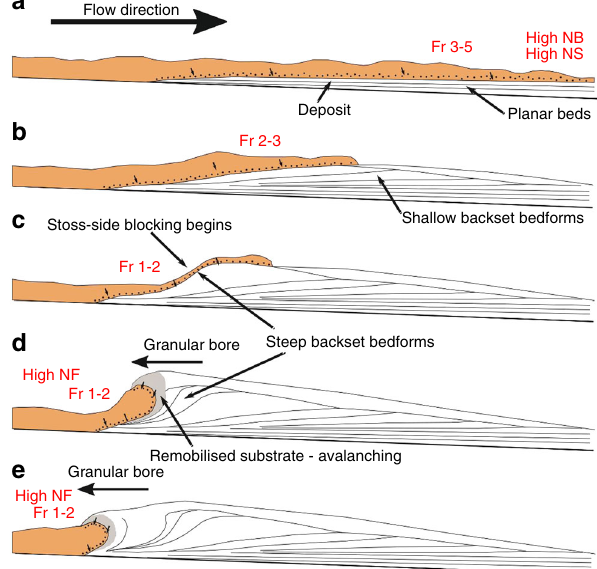
Fig. 8 Schematic showing how different backset bedforms could be deposited by a PDC. Flow properties in red ( Fr , N S , N B , N F ) refer to the Froude, Savage, Bagnold and Friction numbers, respectively. See text for detailed description.